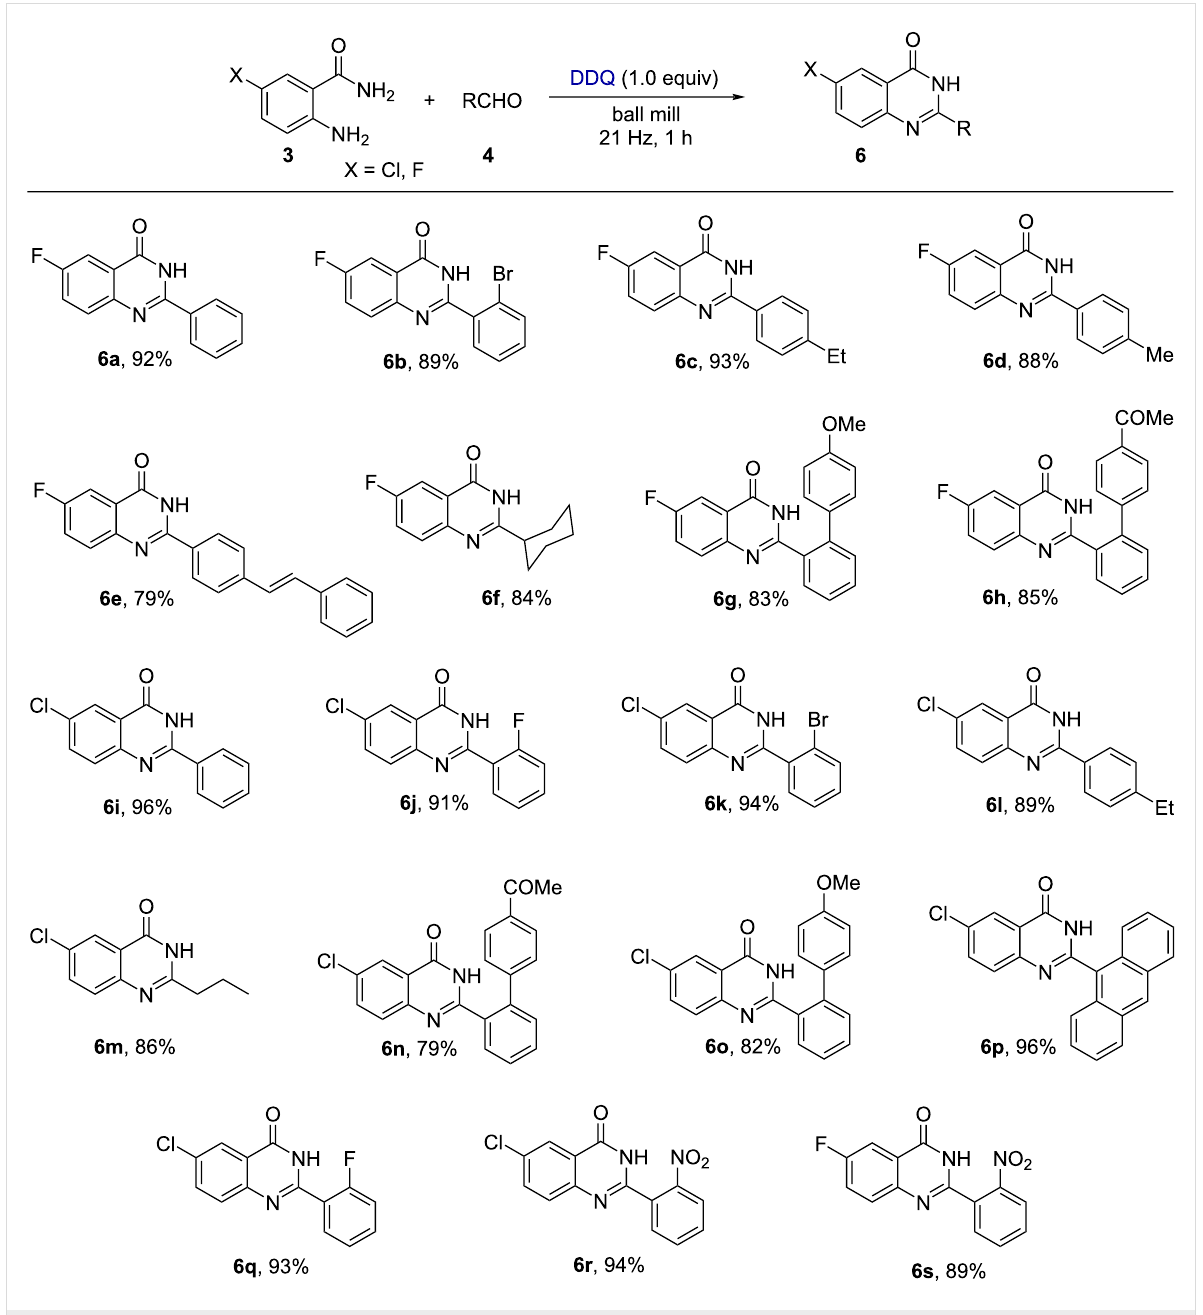
Figure 4: The substrate scope for the synthesis of quinazolin-4(3 H )-one derivatives.